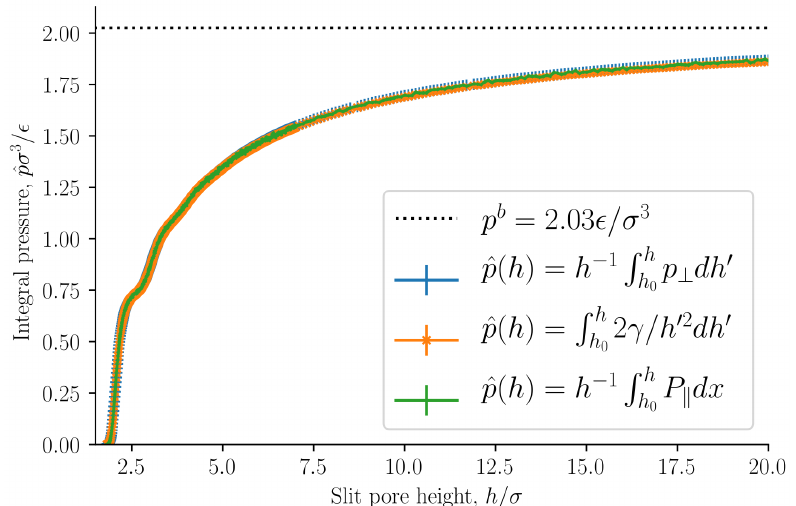
Figure 6. Integral pressure ˆ p as a function of slit pore height h . The integral pressure is computed as the average tangential mechanical pressure, see Equation (34), and from the normal pressure and surface tension, see Equation